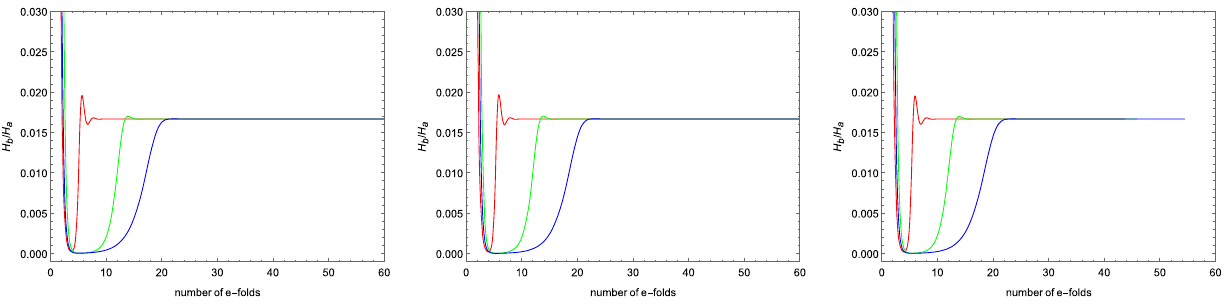
Fig. 3 Time evolution of the ratio H b ( t )/ H a ( t ) for three different val- ues of γ 0 . These plots clearly show that all trajectories converge to the same constant, i.e., H b ( t )/ H a ( t ) → n = ˆ β/ 6 (cid:10) 0 . 0167, confirming